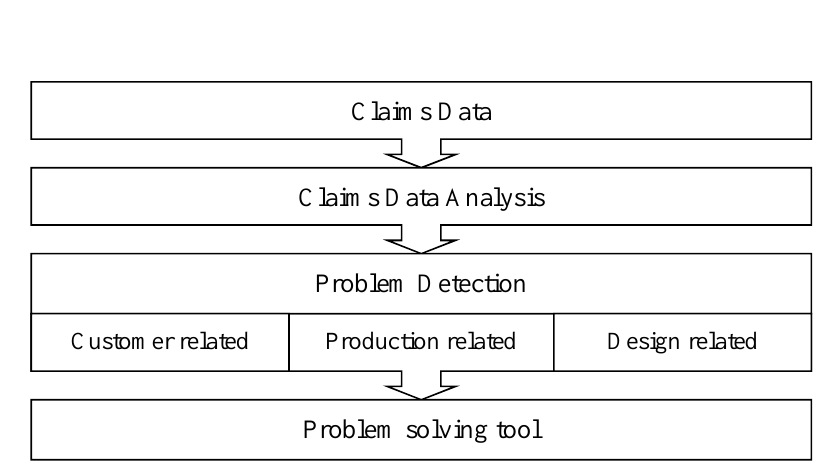
Figure 1 – Claims data analysis flow, adapted from Blischke et al.